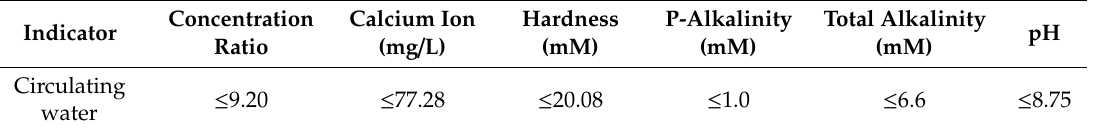
Table 4. Suggested control parameters for circulating